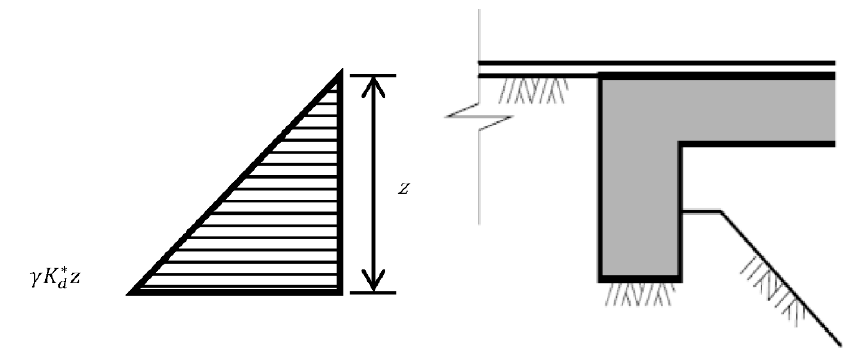
Figure 2. Earth pressure distribution on the bank pad abutment.